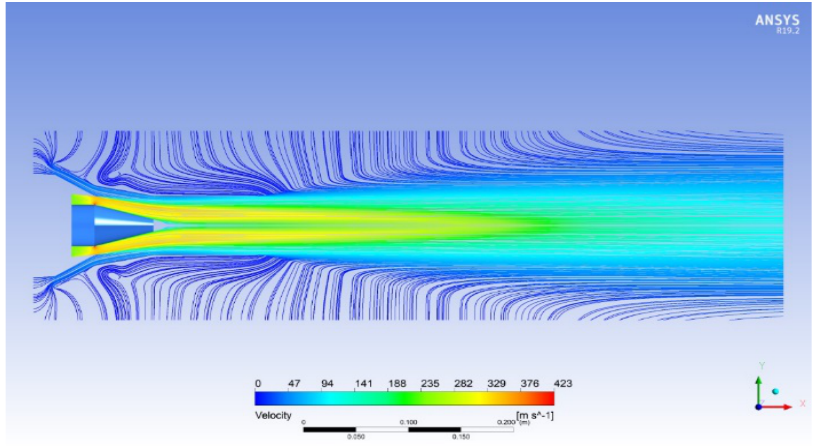
Figure 10. Velocity field and streamlines for the case when section 5 has a value of 8 mm.